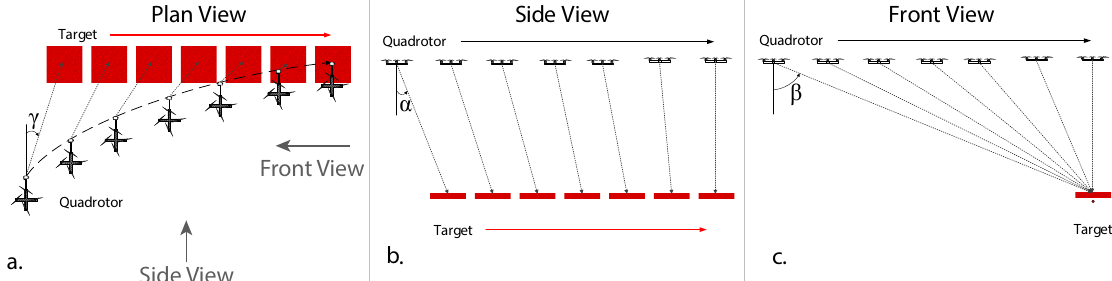
Figure 16. Schematic of a UAV intercepting a moving target. ( a ) Plan view of the interception trajectory; ( b ) Side view and ( c ) Front view. Reproduced with permission from